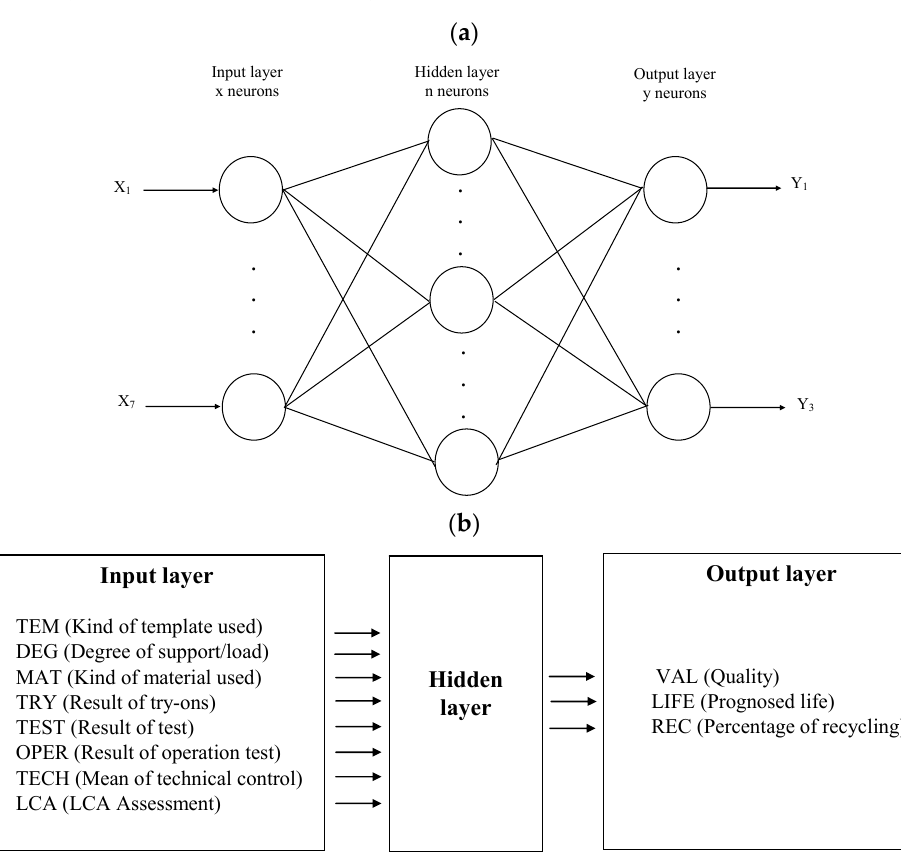
Figure 5. Traditional ANN structure used in the study: ( a ) general structure, ( b ) inputs and out- puts.